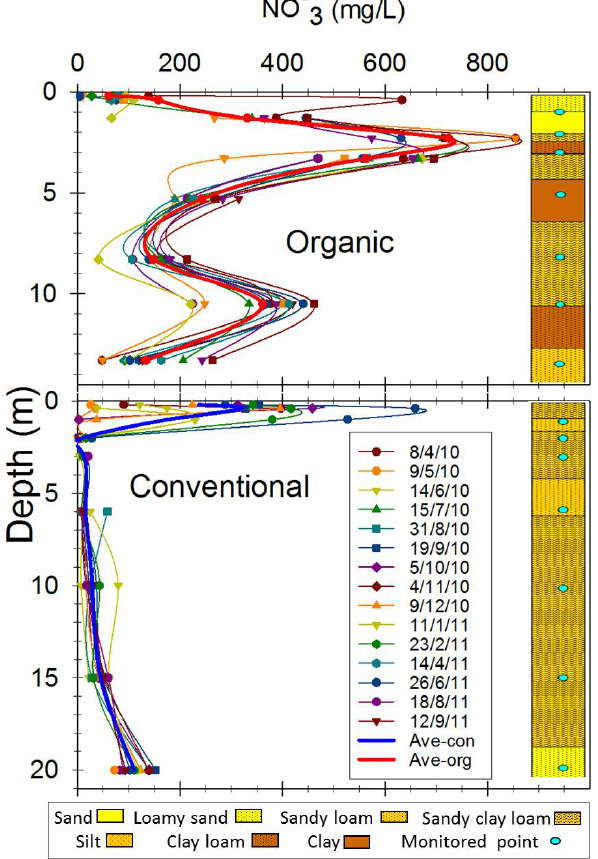
Fig. 3. Nitrate concentrations in the water samples collected by the VMS from the vadose zone underlying the organic and conventional greenhouses along with the lithological cross section of each site. Nitrate profiles were established through 15 sampling campaigns over an 18 month period.